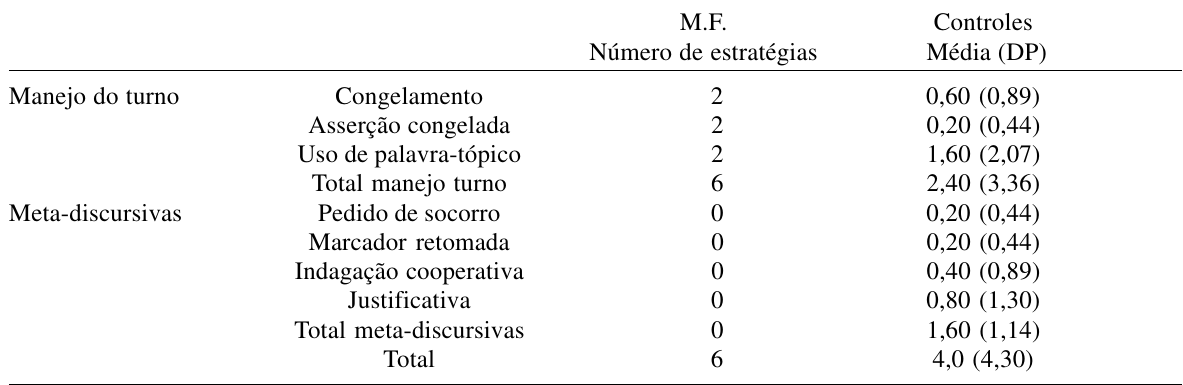
figura seguinte. Ex.: M.F. – “Chapéuzinho é esta... e aqui esta também , não?